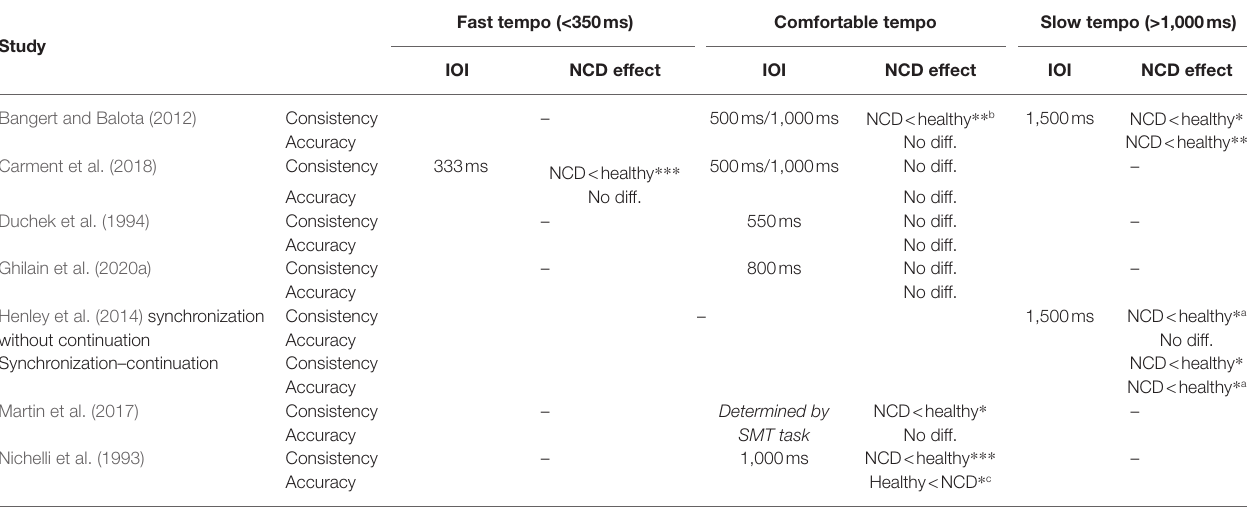
TABLE 4 | Studies investigating paced tapping in people with and without neurocognitive disorders.